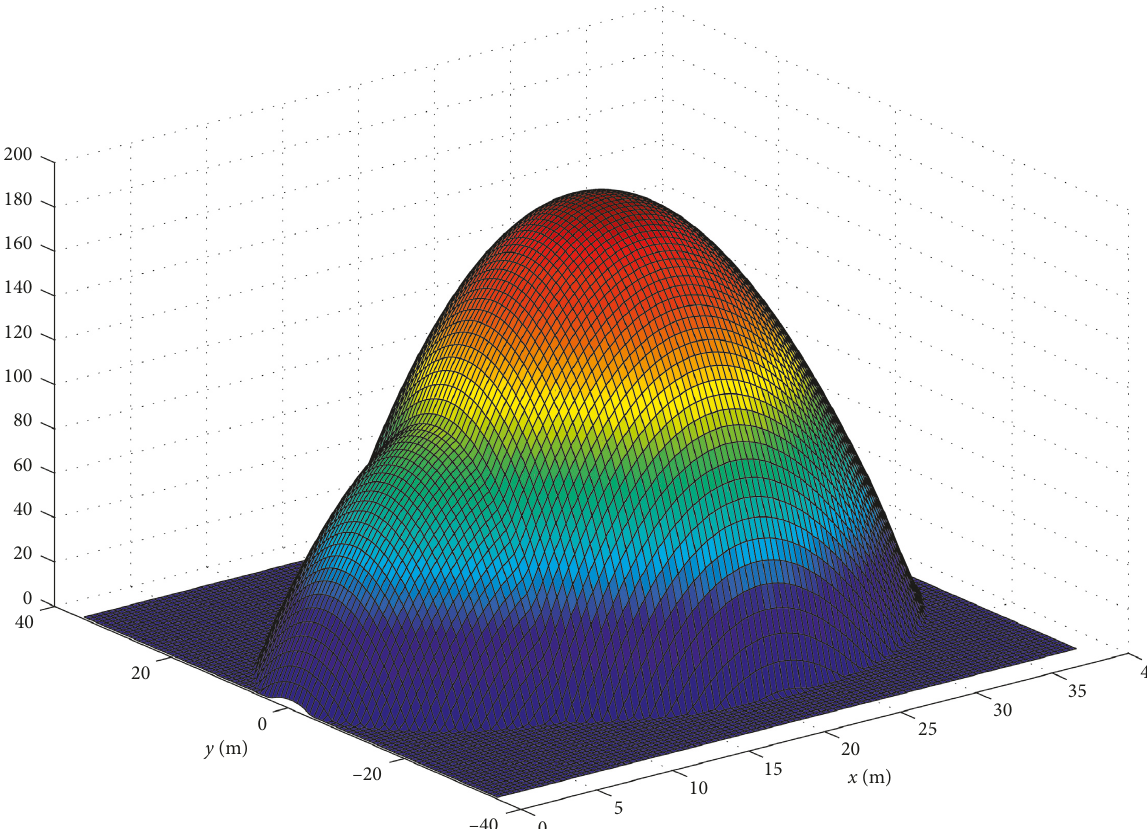
Figure 7: The distribution of normal stresses for case